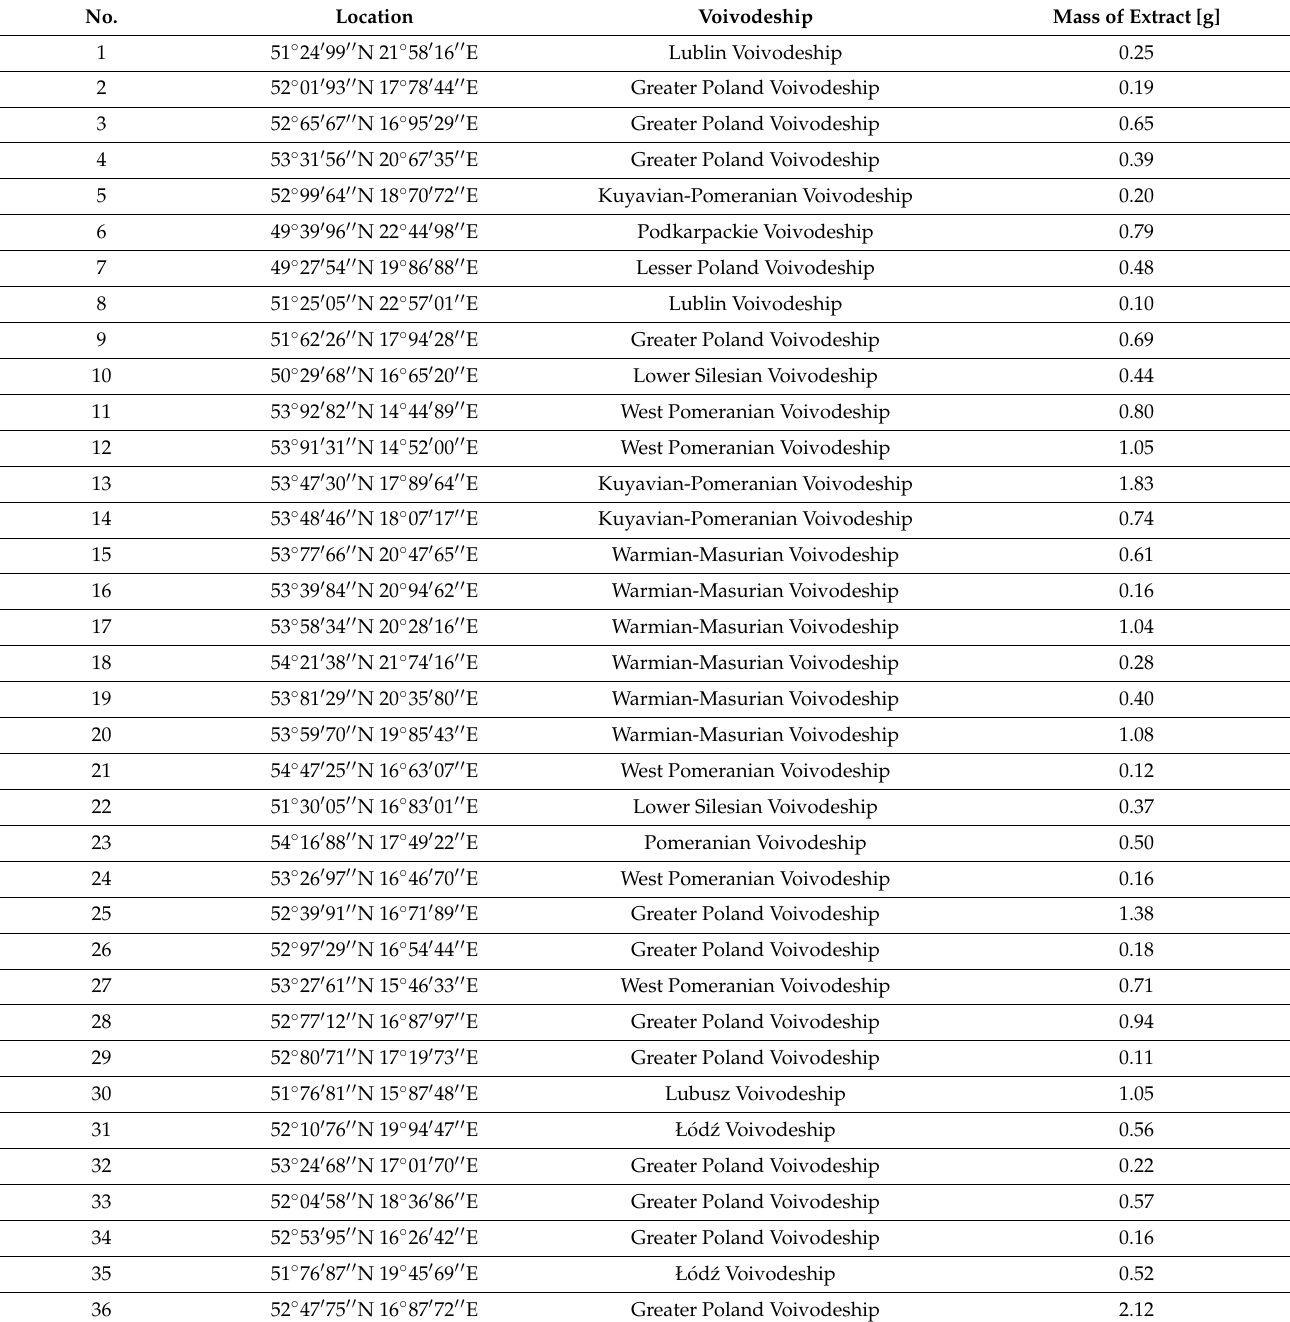
Table 8. The mass of the extract obtained from individual Sambucus nigra L.